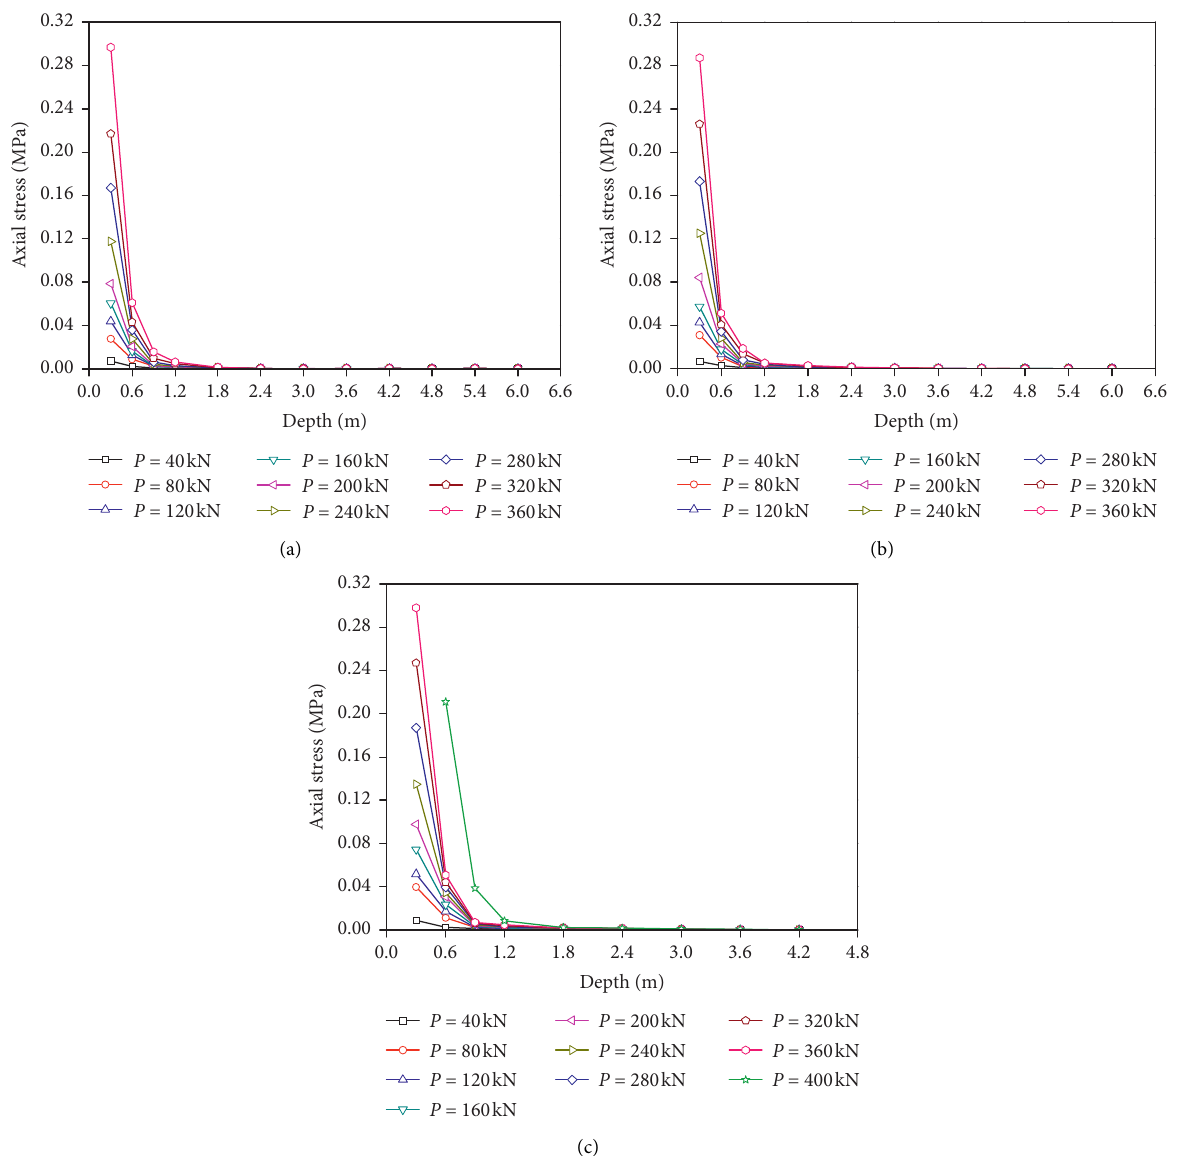
Figure 13: Axial stress of anchor cross-section at different depths: (a) G-28-6.5-1, (b) G-28-6.5-2, and (c)